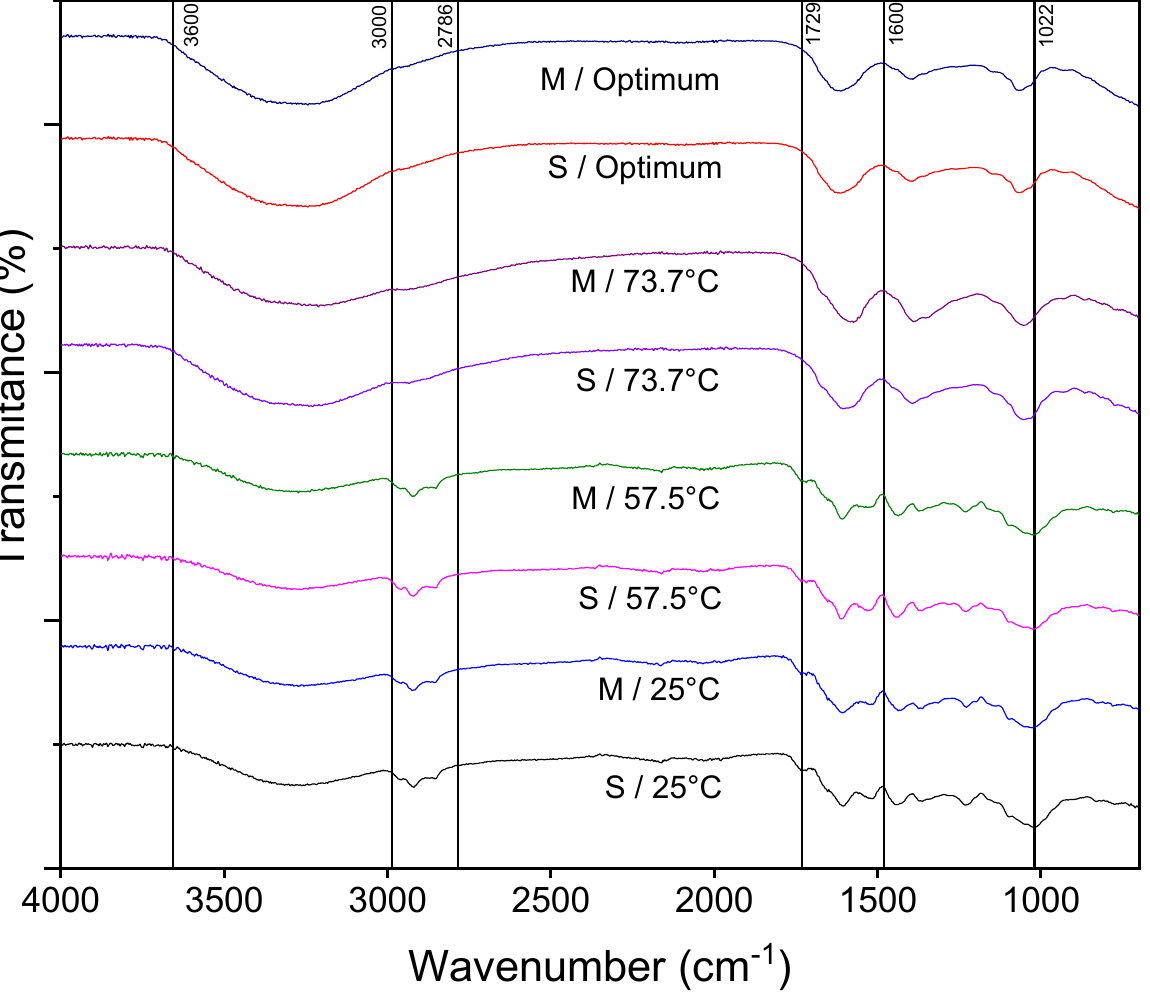
Figure 2. FTIR spectra of hop extract samples SummitMT (S) and Hull Melon GermanyMT (M).